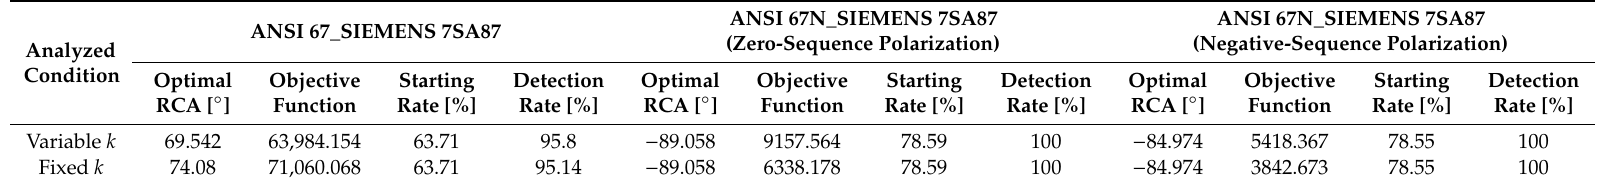
Table 1. Obtained results for the 7SA87 relay at LT_1 SE_A and optimal RCA.